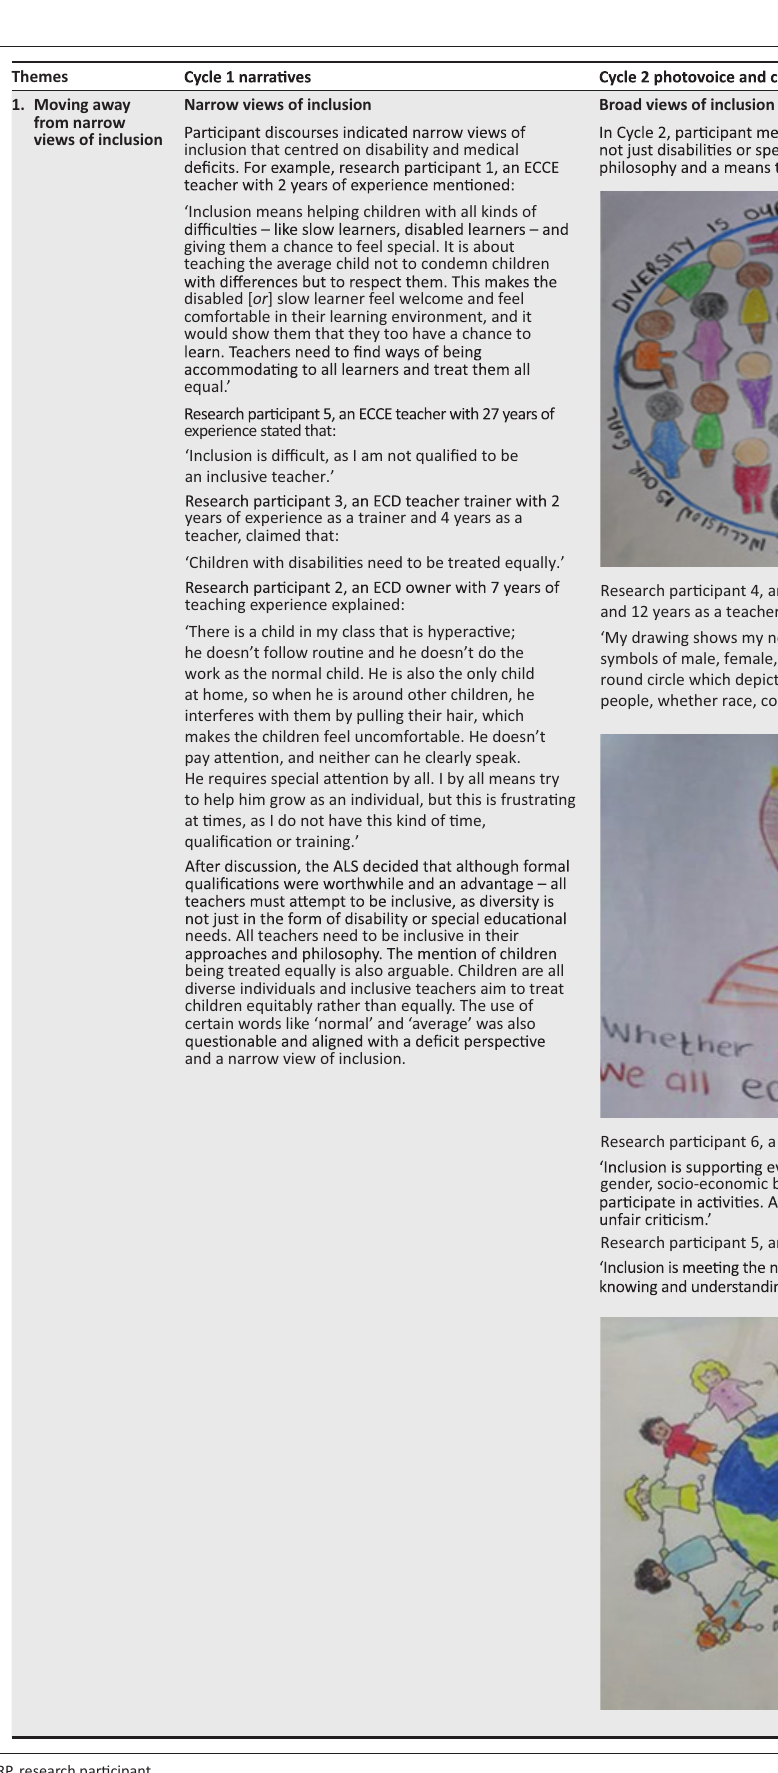
FIGURE 1: Participants’ photovoice, captions and narratives for cycles 1 and 2.